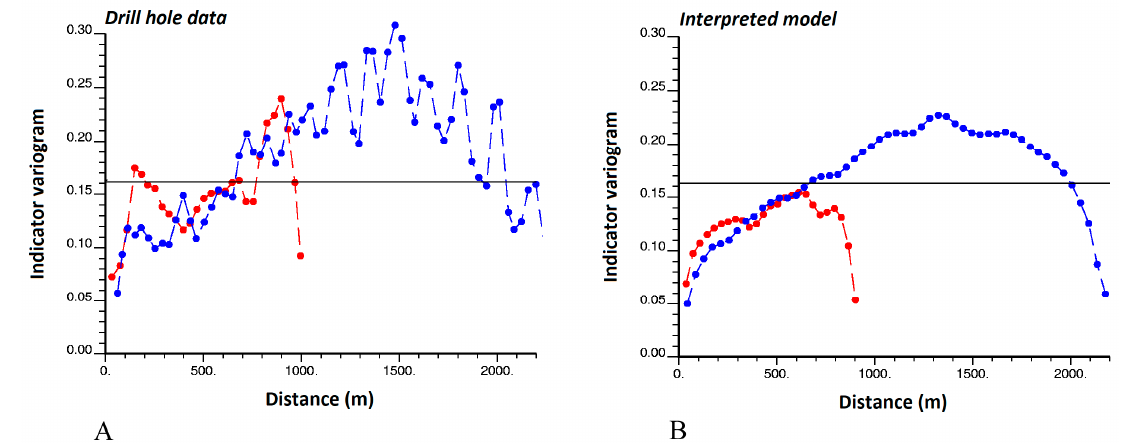
Figure 6. Indicator direct variogram of rock type 1 (andesite) along directions dipping 30° (blue) and − 60° (red) with respect to the north direction, calculated from ( A ) drill hole data, ( B ) interpreted model. Calculations consider an angle tolerance of 20° around the target directions. The same lag values have been used for both variograms.